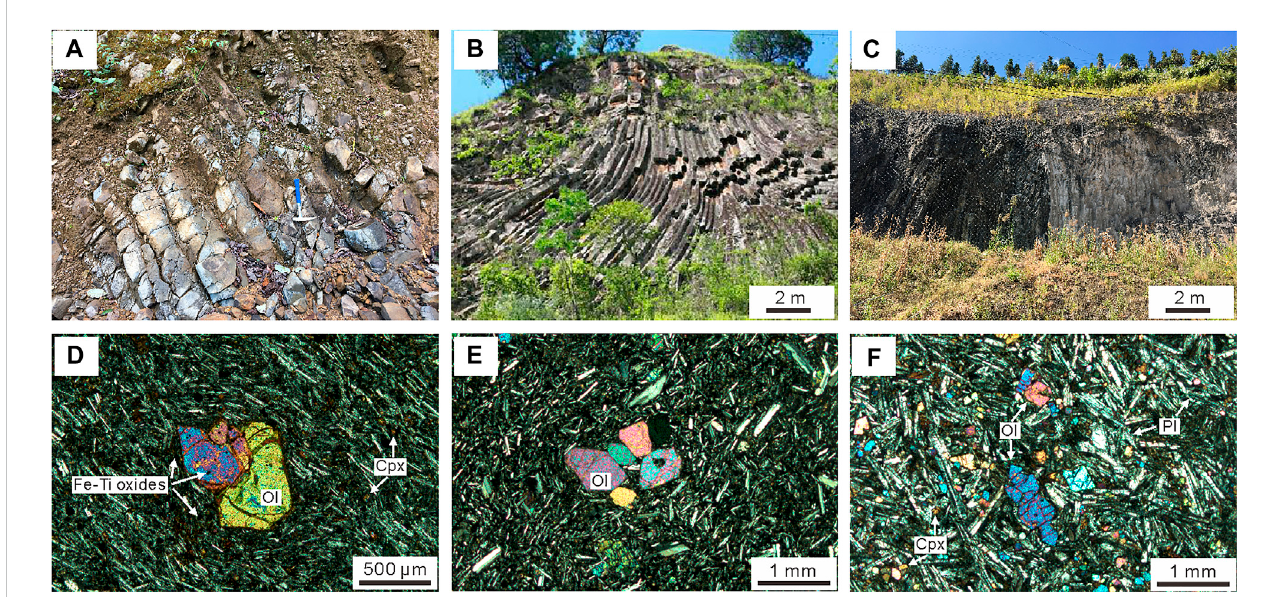
FIGURE 2 Photographs of the Tengchong basalts in the fi eld and photomicrographs under cross-polarized light. (A) Columnar jointed basalt in Sudian County in the western area. (B) Columnar jointed basalt in Qushi County in the central area. (C) Columnar jointed basalt in Tuantian County in the eastern area. (D) Euhedral olivine (Ol) phenocrysts in a groundmass containing lath-shaped plagioclase (Pl), clinopyroxene (Cpx) phenocrysts distributed between plagioclase grains, and Fe-Ti oxides distributed in olivine and between plagioclase grains. This photomicrograph is of trachybasalt sample TC20037. (E) Euhedral olivine (Ol) phenocrysts in a groundmass containing lath-shaped plagioclases in trachybasalt sample TC20050. (F) Olivine and clinopyroxene phenocrysts surrounded by lath-shaped plagioclases in basalt sample